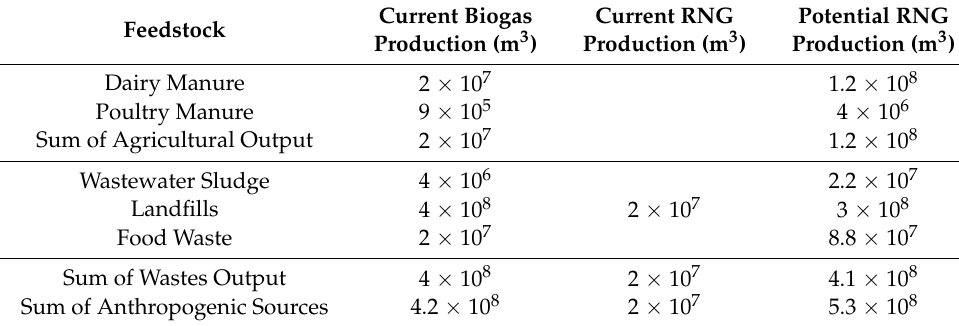
Table 4. Current annual biogas and RNG production for New York State.